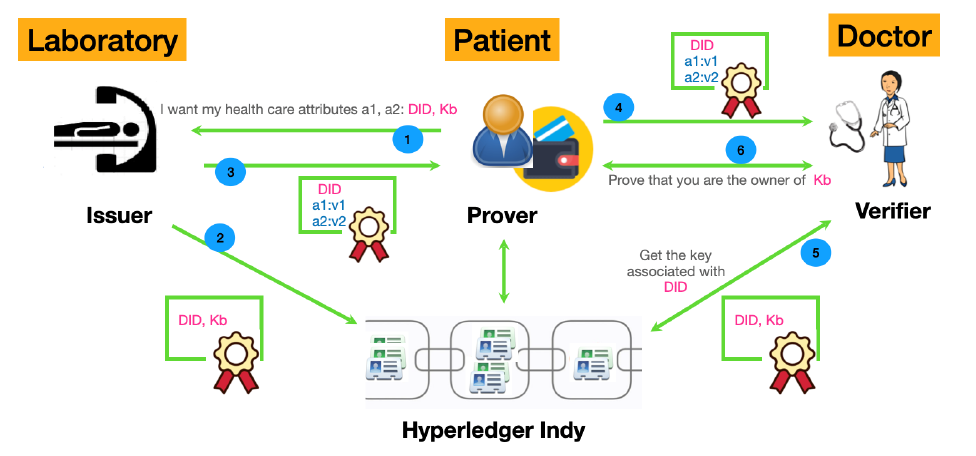
Figure 2. EHRs management based on